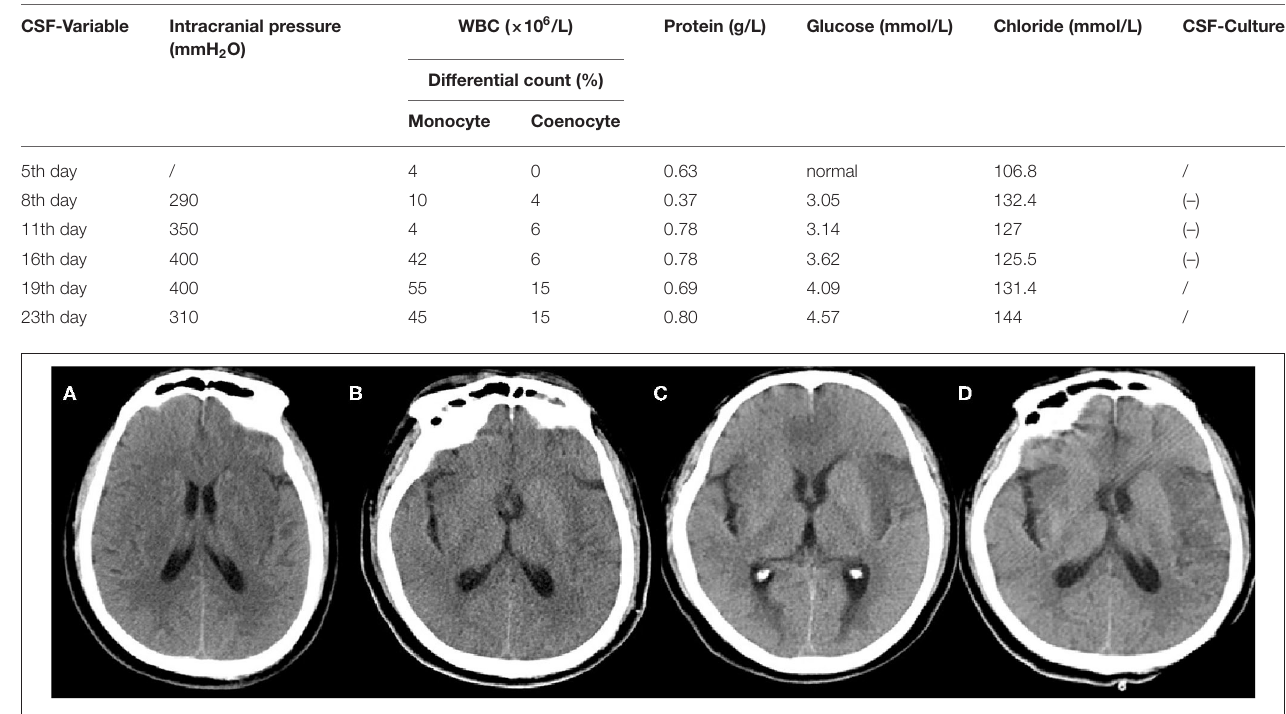
TABLE 1 | Dynamic CSF analysis over the course of hospitalization.